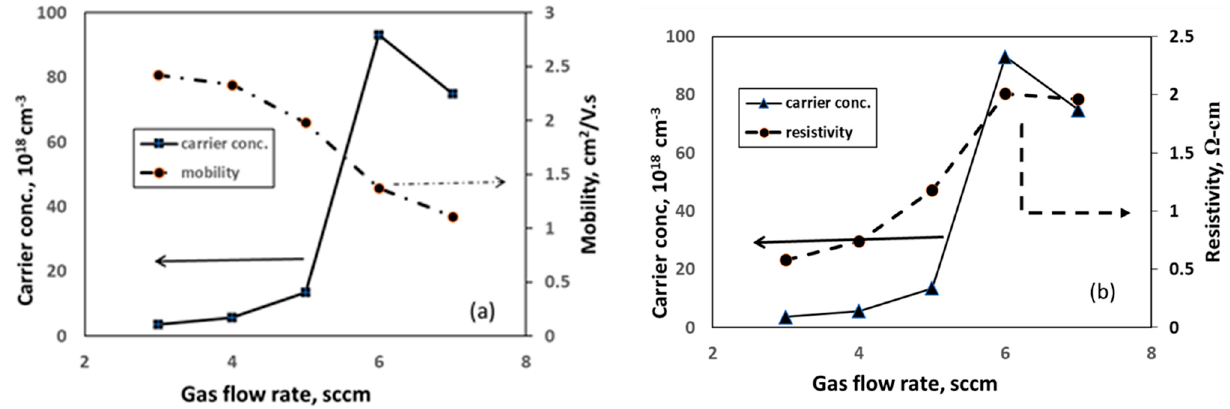
Figure 13. Electrical properties of as-grown WS 2 thin film under different Ar gas flow rates: ( a ) carrier concentration and mobility ( b ) carrier concentration and resistivity .